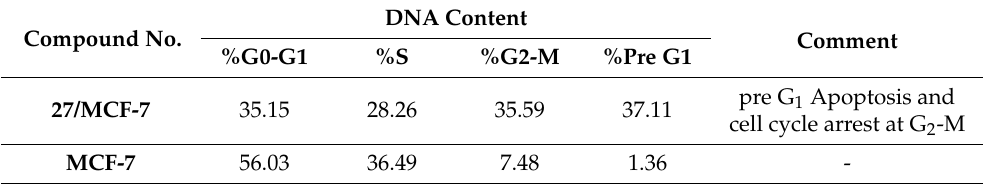
Table 3. Evaluation of DNA content and apoptosis induced by compound 27 on MCF-7 cell lines versus control a